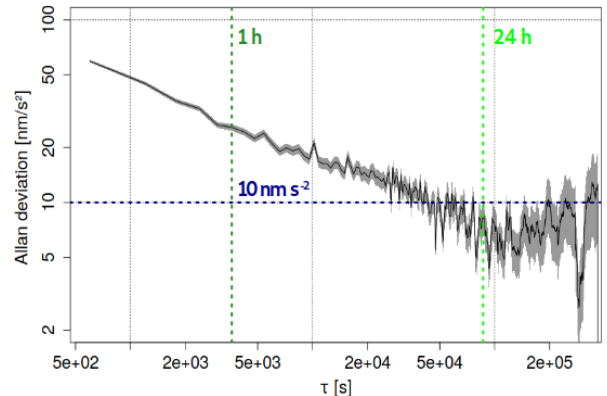
Figure 8. Allan deviation of 10min AQG-B01 data obtained during operation in a garage in Montpellier. The horizontal blue dashed line shows the sensitivity benchmark of 10nms − 2 , the dark green vertical dashed line signifies the integration period of 1h, and the light green one that of